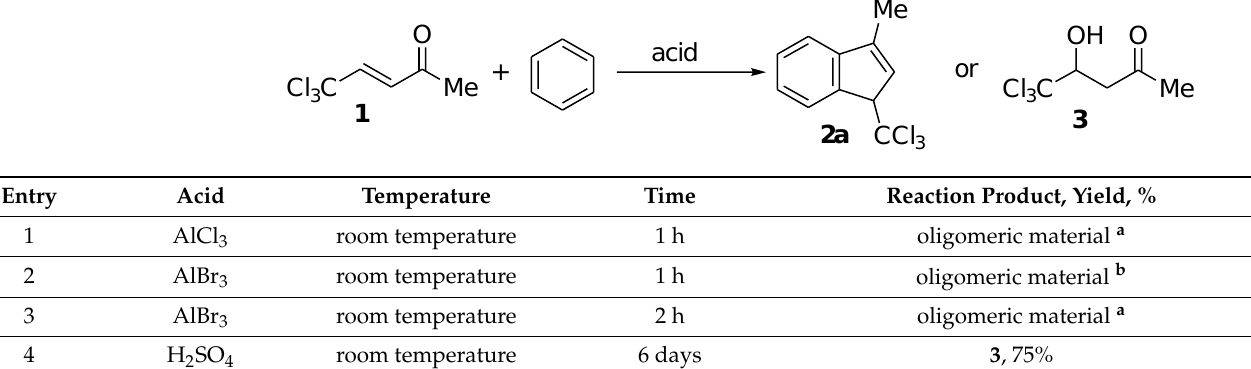
accompanied by cationic oligomerization processes, which leads to a decrease in the yield of the target compound. The formation of indene 2a points out that the starting compound 1 in CF 3 SO 3 H behaves as a precursor of the bi-centered electrophile, with reactive cationic Table 3. Reactions of CCl 3 -enone 1 with benzene under the action of excess of various acids.